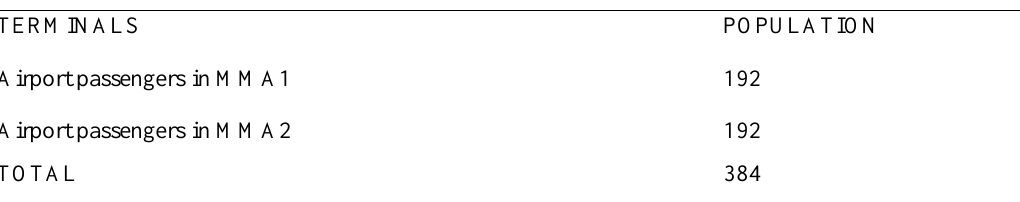
Table 1. Sample Population